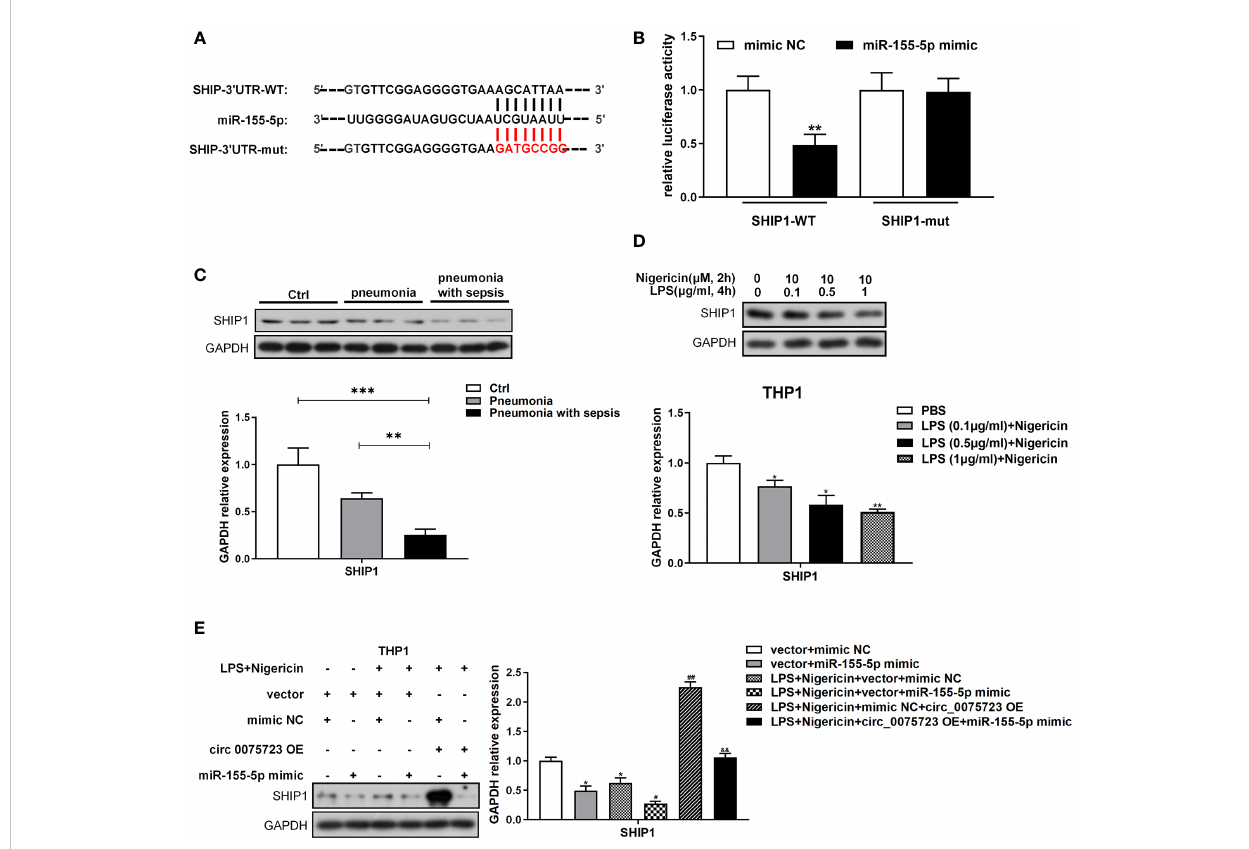
FIGURE 5 Circ_0075723-miR-155-5p ceRNA modulates macrophage pyroptosis by directly regulating SHIP1. (A) Schematic showing the predicted miR-155-5p sites in SHIP1. (B) Dual-luciferase reporter assay was performed to validate the association between miR-155-5p and SHIP1. Data are presented as means ± SD; signi fi cant difference was identi fi ed with one-way ANOVA. **p < 0.01 vs. mimic NC group. (C) Western blot analysis of SHIP1 and GAPDH in CD14+ monocytes from pneumonia-induced sepsis, pneumonia without sepsis and healthy control group. Each group has 4 samples. Data are presented as means ± SD; signi fi cant difference was identi fi ed with one-way ANOVA. **P < 0.01 vs. Pneumonia; ***P < 0.001 vs. Control. (D) Western blot analysis of SHIP1 and GAPDH in THP-1 cells primed with different doses of LPS (0.1, 0.5 and 1 m g/ml) for 4 h and stimulated with nigericin (10 m M) for 2h. Data are presented as means ± SD; signi fi cant difference was identi fi ed with Student t -tests. *p < 0.05 vs. PBS; **p < 0.01 vs. PBS. (E) THP-1 cells were transfected with vector + mimic scrambled control (mimic NC) or vector + miR-155-5p mimic or were transfected with vector + mimic NC, vector + miR-155-5p mimic, mimic NC + circ_0075723 lentivirus plasmids (circ_0075723 OE) or miR-155-5p mimic